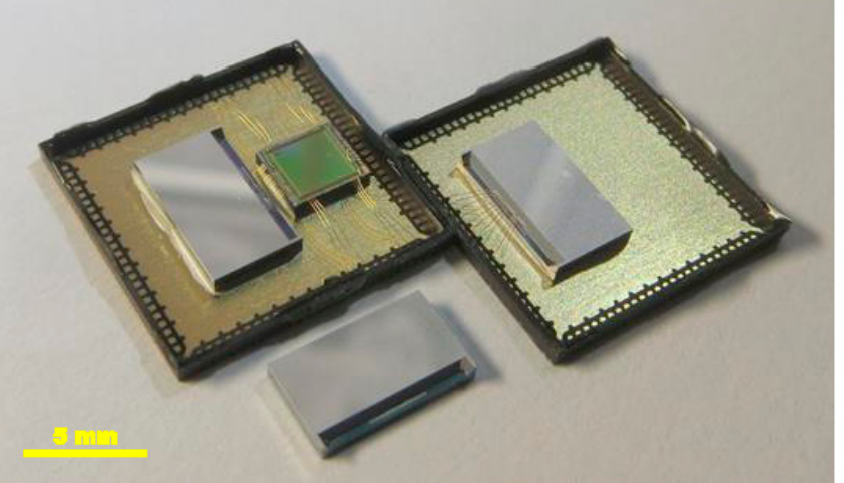
Figure 6. X-axis accelerometer photography.